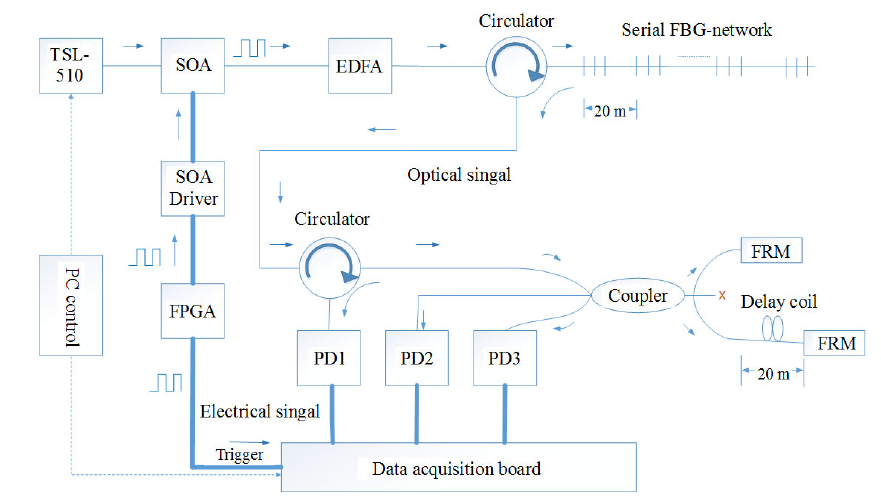
Fig. 5 Distributed weak fiber Bragg grating vibration sensing system structure diagram based on the 3 × 3 fiber